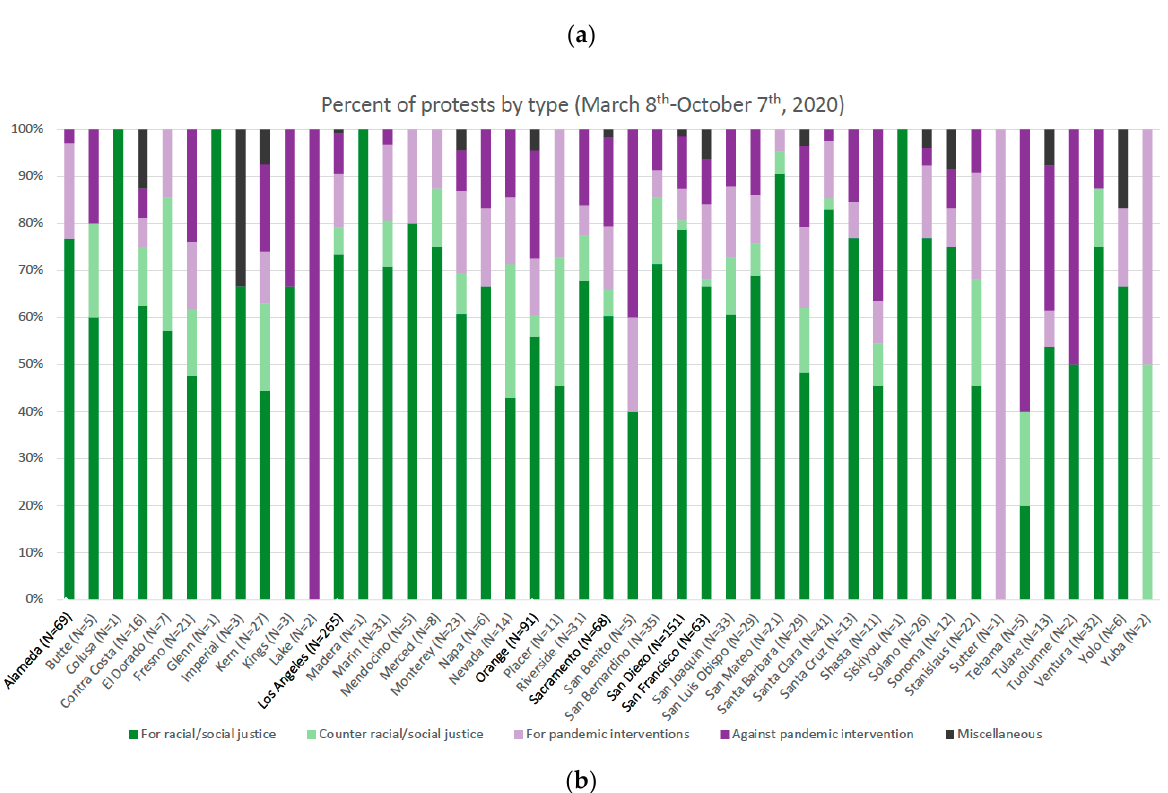
Figure 2. Protest by type over time ( a ) and by county ( b ). N: Total number of protests for a given county during the time period, with the names of counties with > 50 protests bolded.